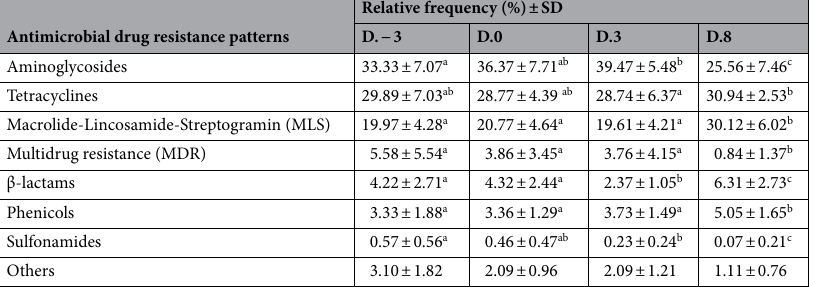
Antimicrobial drug resistance